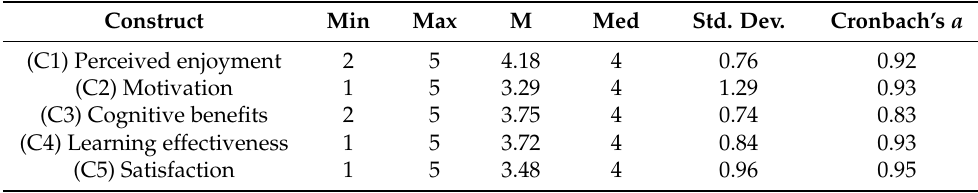
Table 3. Descriptive statistics for the user experience questionnaire constructs.